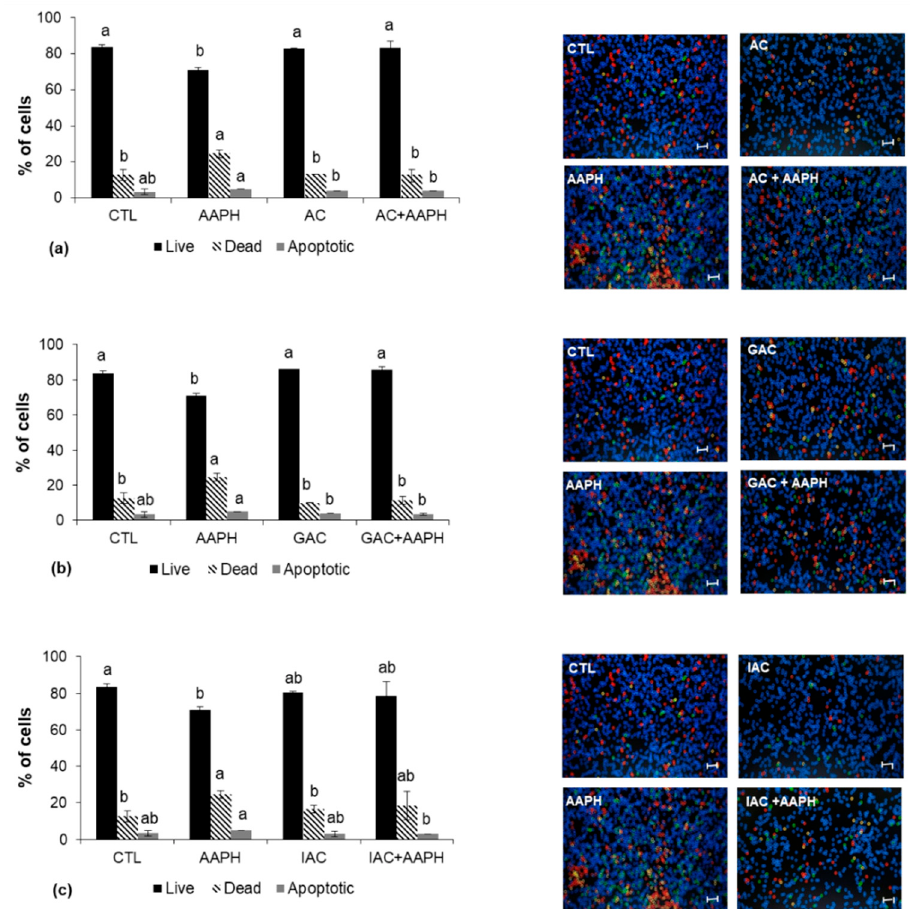
Figure 7. Percentage of live, dead, and apoptotic cells determined by the Tali ® Image-Based Cytometer. Cells were preincubated with ( a ) achene; ( b ) achene after gastric digestion; ( c ) achene after intestinal digestion and then stressed with AAPH for 24 h. Values are expressed as the mean ± SD of three independent experiments ( n = 3). Columns belonging to the same set of data with different superscript letters are significantly different ( p < 0.05). Representative images of apoptosis quantification are shown following the graphs (stressed cells appear red). Scale bar: 50 µ m. CTL: cells without treatment; AC: cells incubated with the achene; GAC: cells incubated with achene after gastric digestion; IAC: cells incubated with achene after intestinal digestion; AAPH: cells incubated with AAPH; AC + AAPH: cells preincubated with the achene and then stressed with AAPH; GAC + AAPH: cells preincubated with achene after gastric digestion and then stressed with AAPH; IAC + AAPH: cells preincubated with achene after intestinal digestion and then stressed with AAPH.